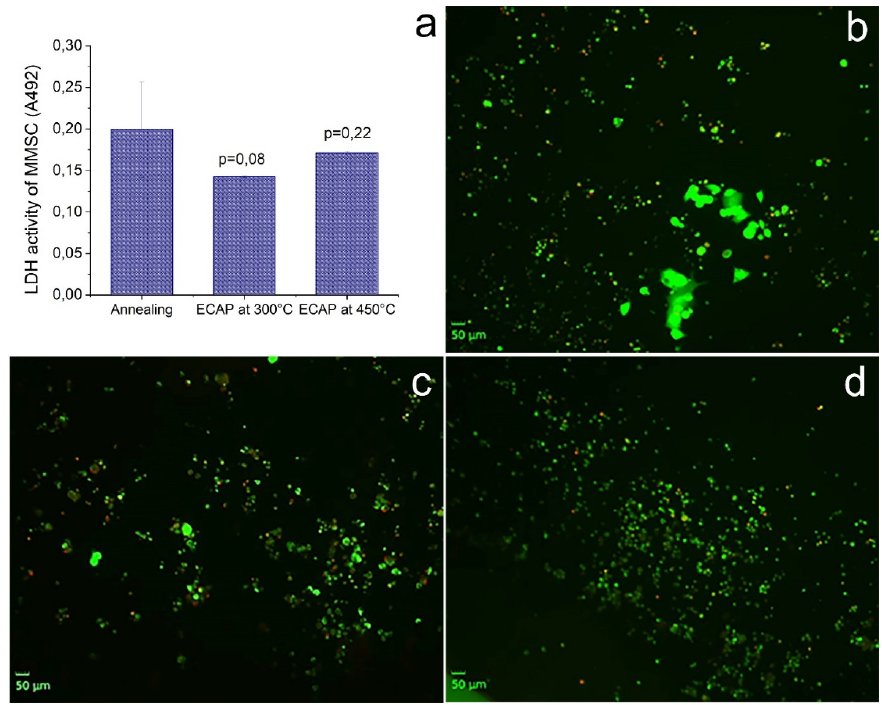
Figure 8. Cells colonization of the surface of Fe–Mn–Pd alloy samples in the initial state and after ECAP in two modes. LDH activity of MMSC ( a ) and fluorescence microscopy of MMSC colonized the surface of samples: annealed ( b ); ECAP-treated at 300 °C ( c ); ECAP-treated at 450 °C ( d ). Cells with a compromised membrane that are considered to be dead or dying were stained red, whereas live cells with intact membranes were stained green.